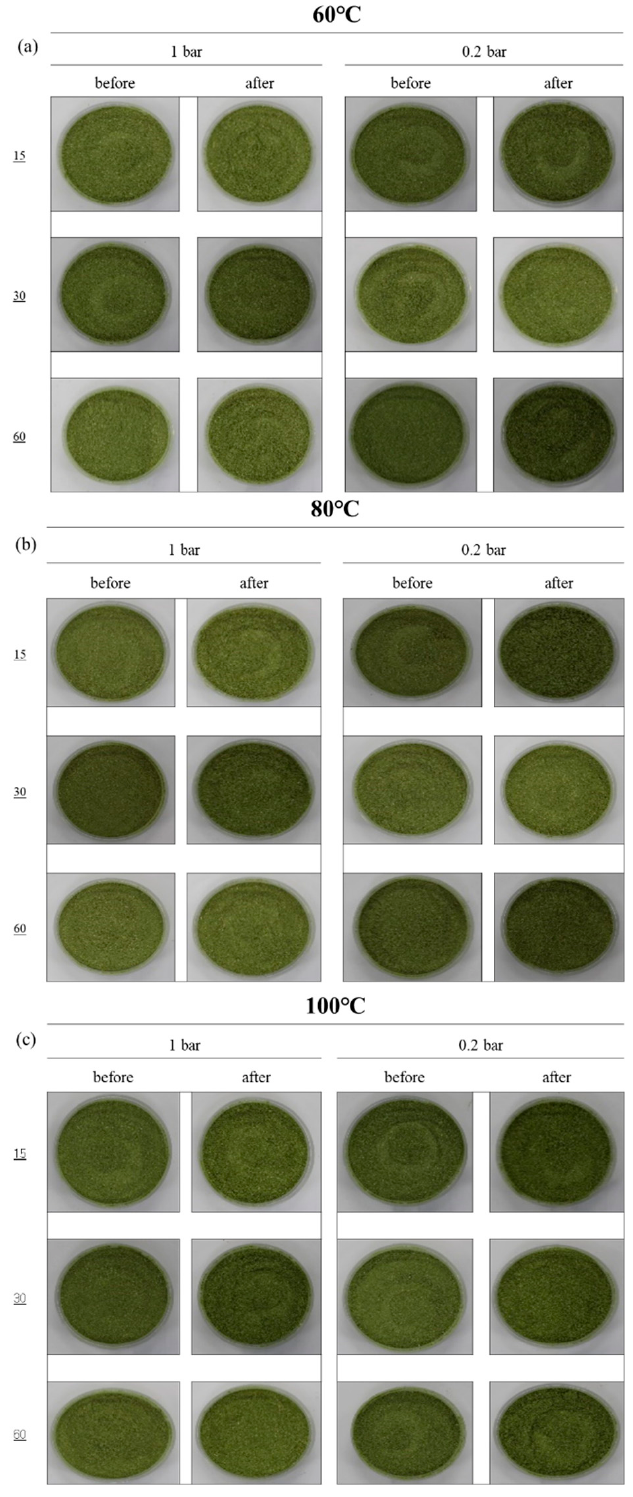
Figure 9. The images of sprout barley powder samples before and after treatments with different heating conditions.